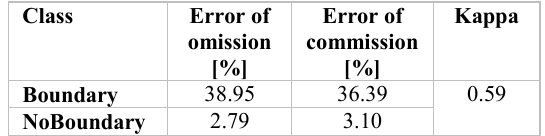
Table 5. Accuracy Assessment for Example